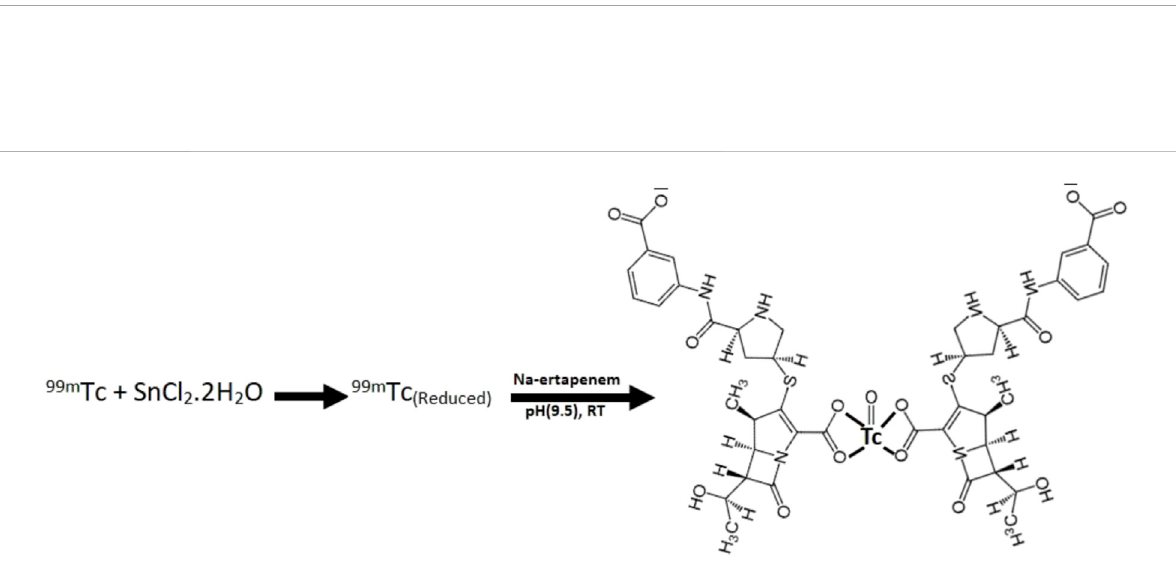
FIGURE 3 (A) Effectofligand(ertapenem)concentrationonradiochemicalyield; (B) effectofthereducingagent(SnCl 2 effect of pH on radiochemical yield; and (D) effect of reaction time on radiochemical